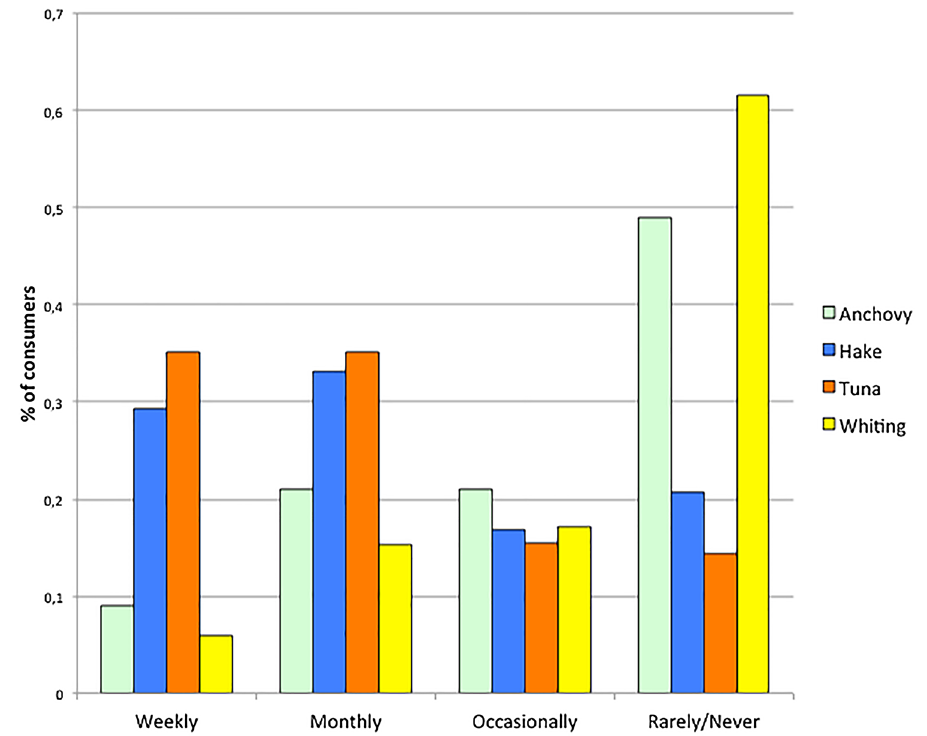
Figure 1. Consumption of the four species. Presented as the proportion of participants in the survey consuming a species weekly, monthly, occasionally or